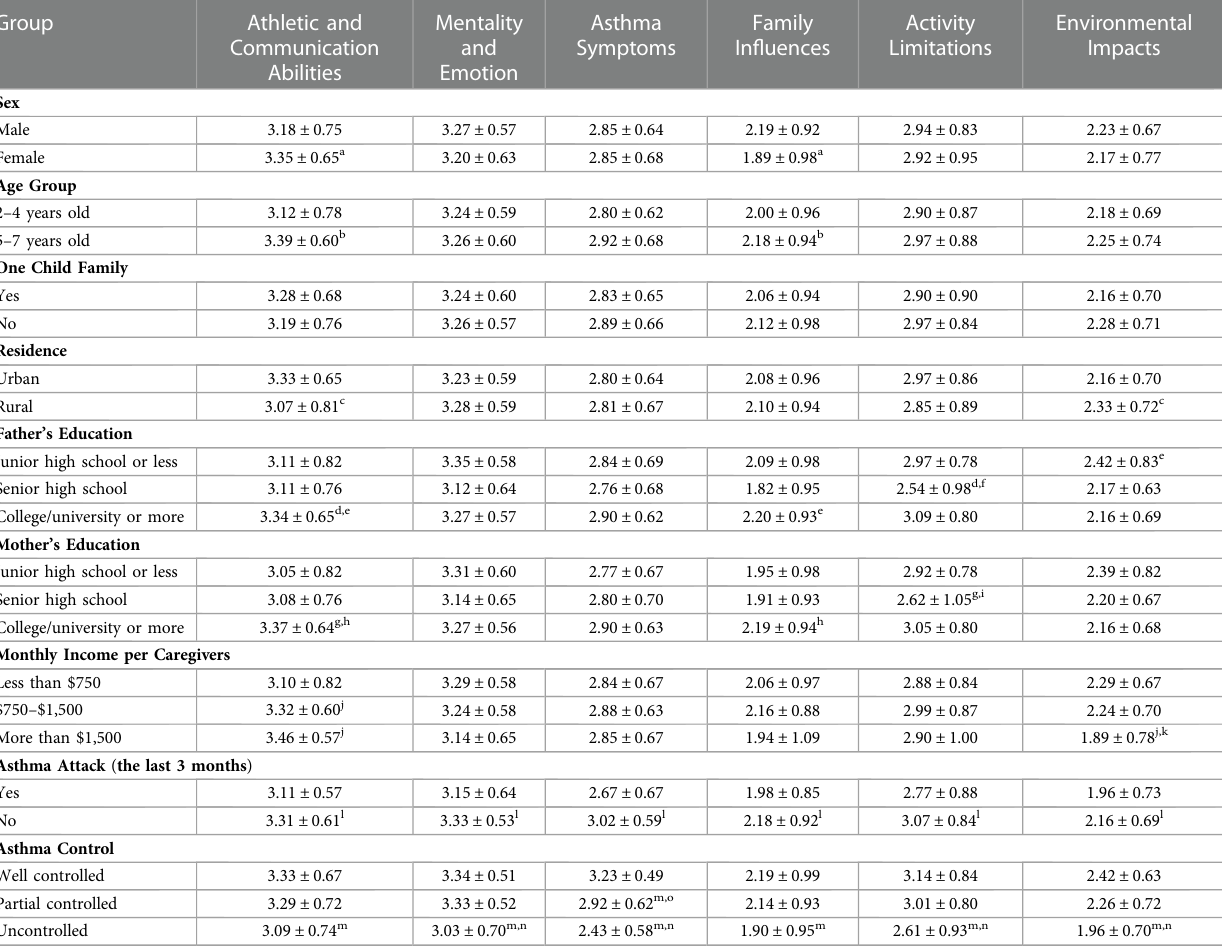
TABLE 4 Comparison of each dimension score of patient reported outcomes questionnaire of children with asthma reported by caregivers among different characteristics of children and their caregivers in the third investigation of the questionnaire ( n =326).